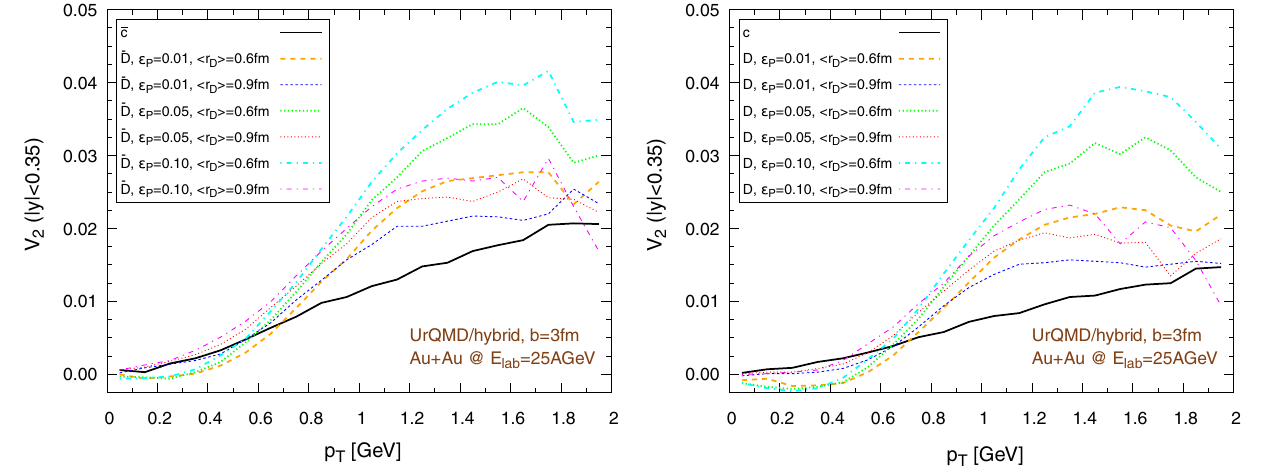
Fig. 23 Au+Au collisions at E lab = 25AGeV, b = 3fm in the UrQMD/hybrid model. Elliptic flow of charm quarks and D-mesons ( | y | < 0 . 35).Weexploretheeffectofdifferentchoicesofthehadroniza-